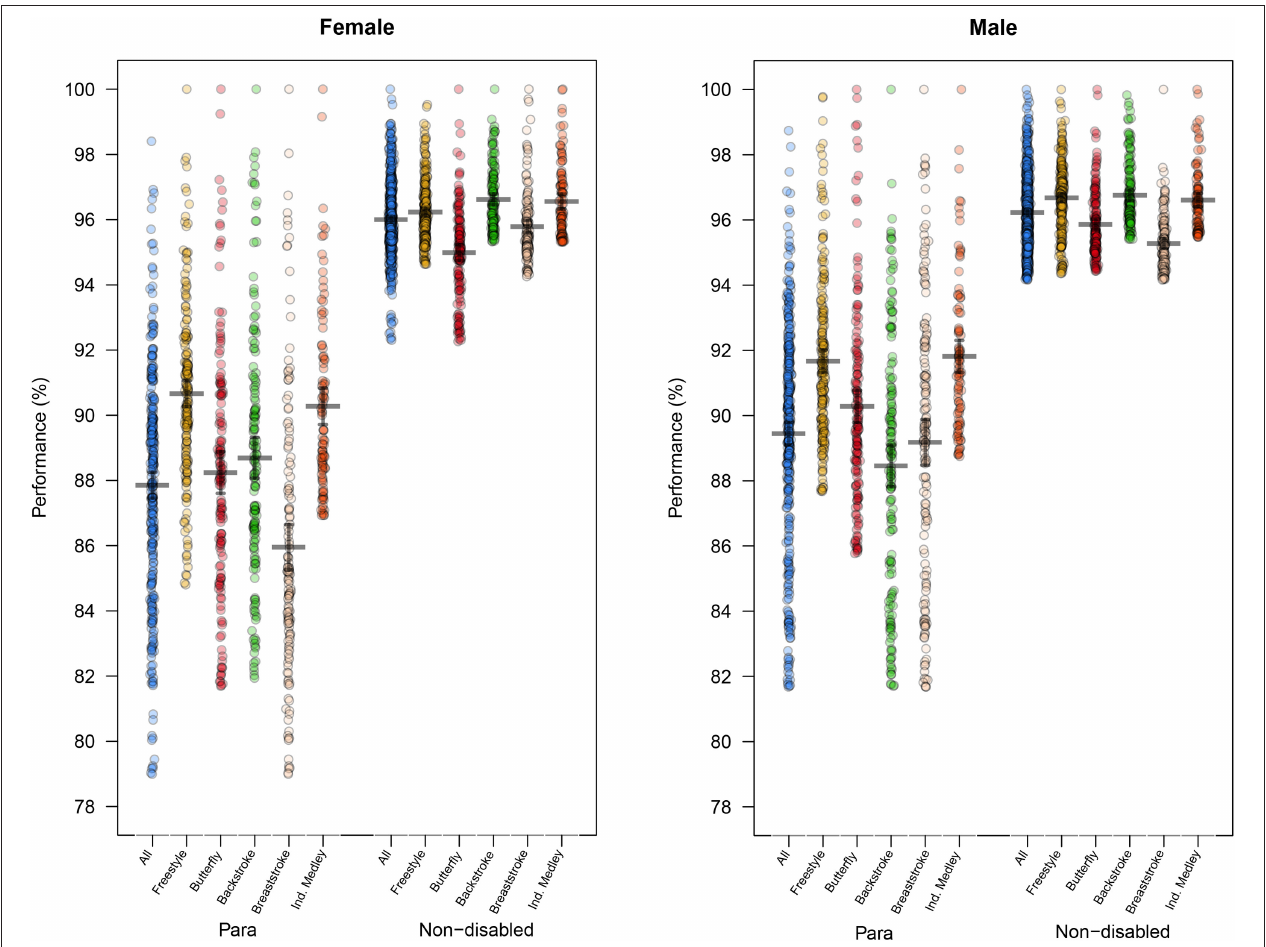
FIGURE 3 | Competition Performance Level: mean ( ± SD ) performance levels of each swimmer in % compared to the best performance by events according to sex and stroke for Para swimmers and non-disabled swimmers.